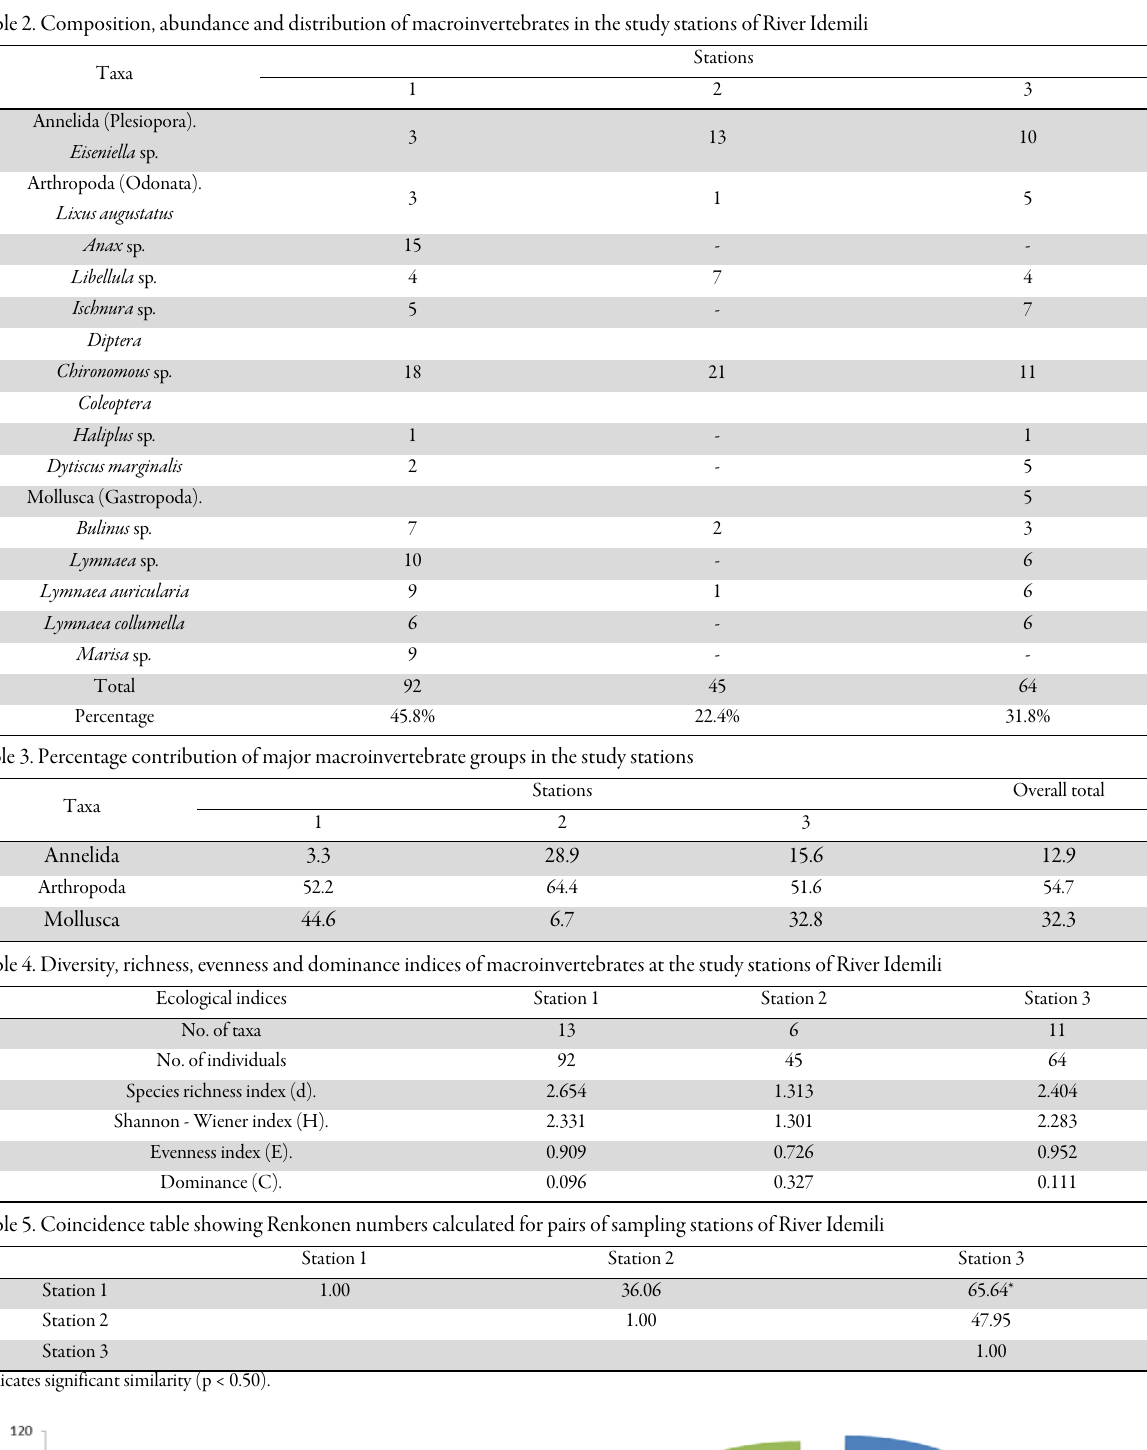
Table 2. Composition, abundance and distribution of macroinvertebrates in the study stations of River Idemili Taxa Annelida (Plesiopora). Eiseniella sp .